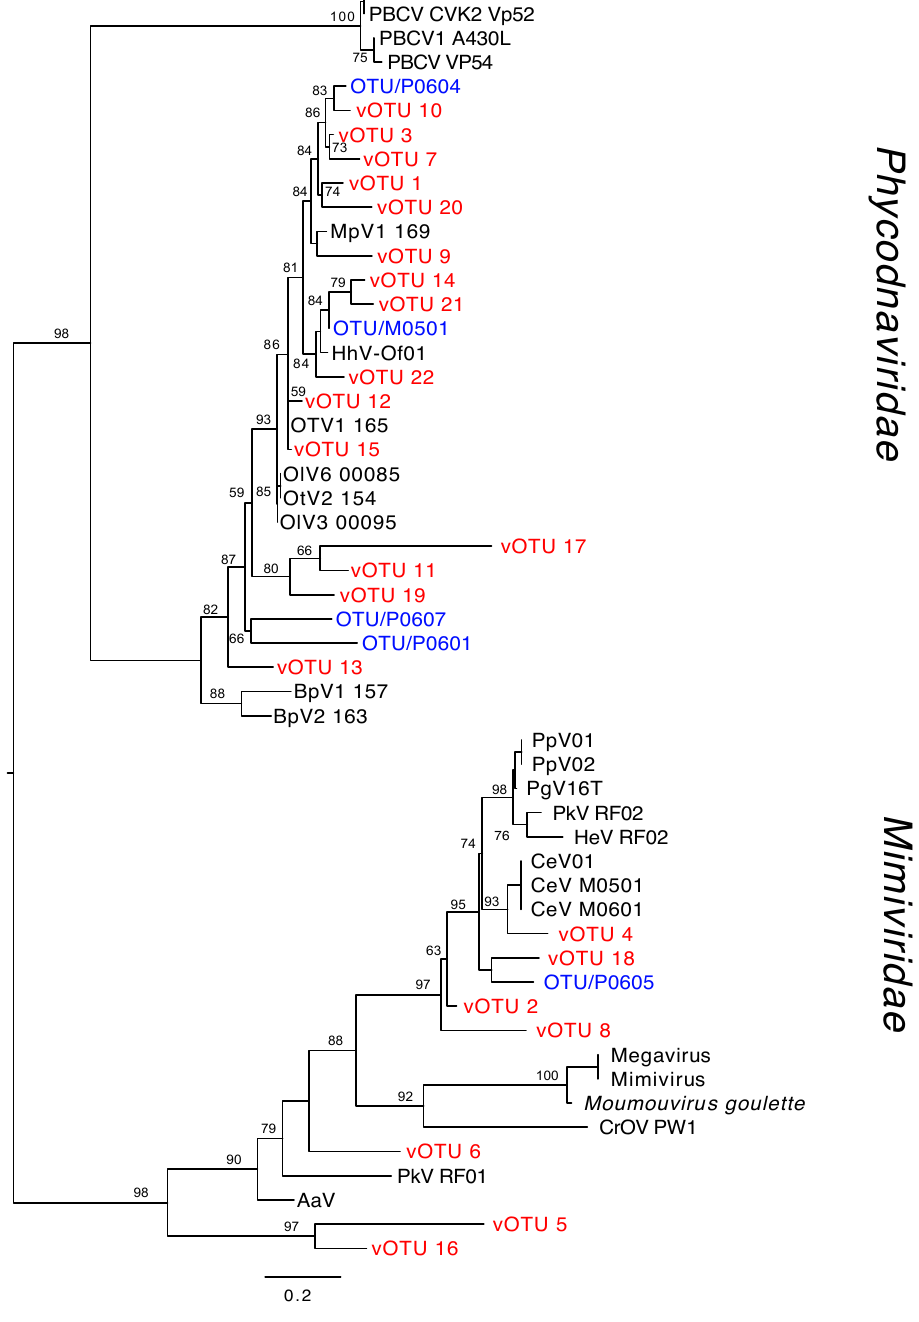
Figure 1. Phylogenetic tree based on relevant Phycodnaviridae and Mimiviridae major capsid protein (MCP) reference sequences (black), virus Operational Taxonomic Units (OTUs) found in a previous study in Raunefjorden (blue [35]), and the 22 most abundant viral OTU (vOTU) algal viruses ( > 50 reads) from Outer Oslofjorden (red). Bootstrap values > 50 are shown at the